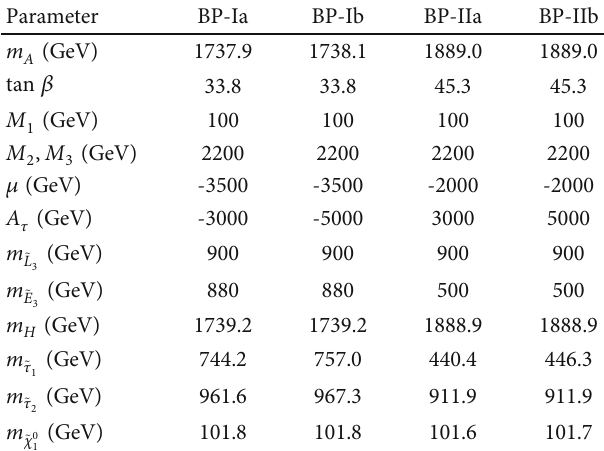
Table 6: Benchmark points.